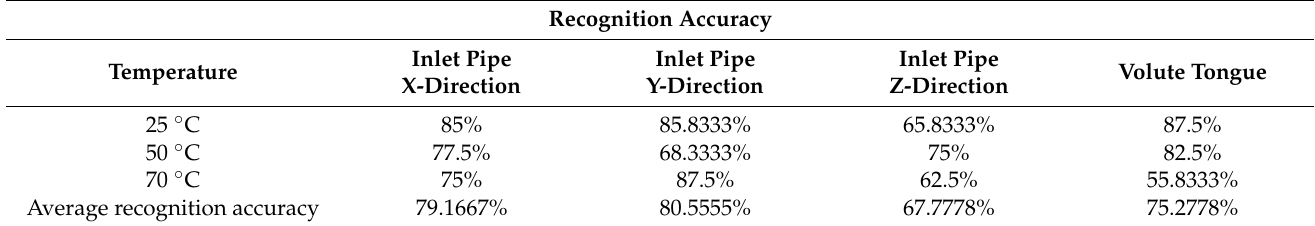
Table 6. Accuracy of multi-classification recognition of time frequency domain combined eigenvalues.